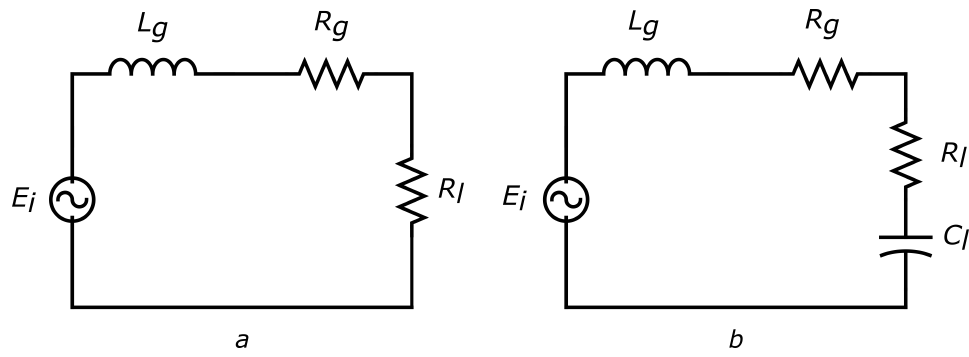
Figure 6. Equivalent circuit of linear generator single phase for: ( a ) R -load; ( b ) RC